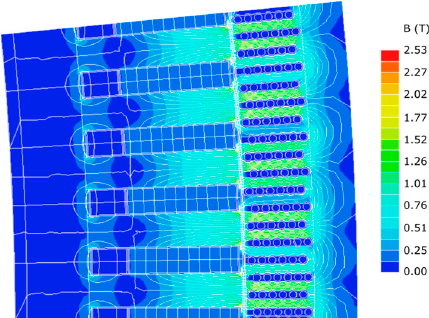
Figure 7. Magnetic field lines in the LG for Case 7, where 75% of the PM is Y40 and 25% is Y30 and the pole shoe is T-shaped.